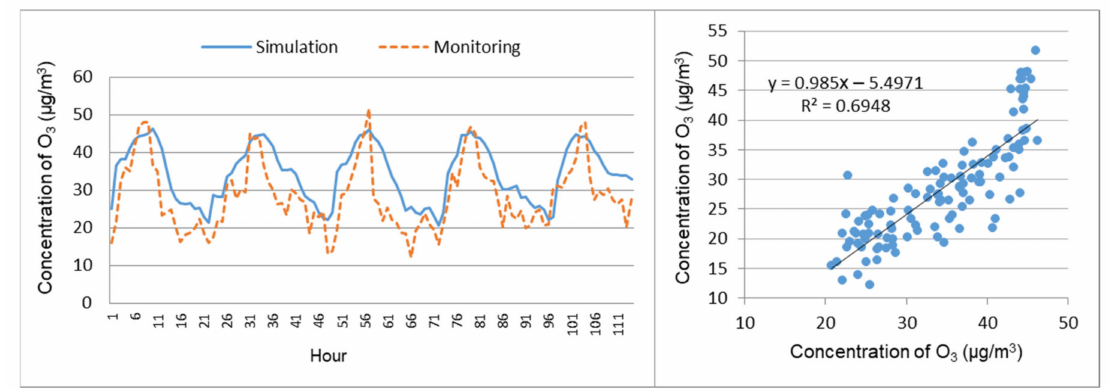
Figure 1. Comparison of simulation and monitoring data for O 3 at Nguyen Van Cu station